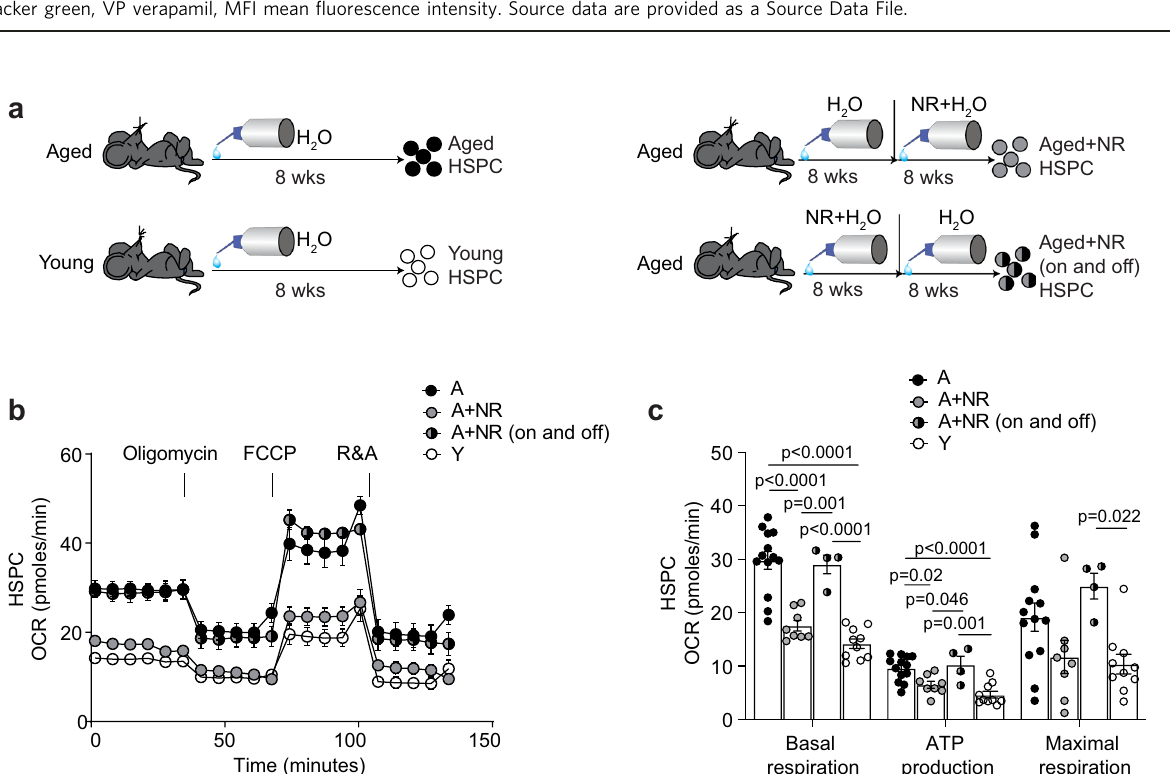
Fig. 5 NR treatment decreases stress response and mitochondrial network size. a mRNA expression levels of heat shock protein Hspa1a in aged ( n = 5, biological replicates), NR-treated aged ( n = 5, biological replicates) and young HSC ( n = 5, biological replicates). Data are expressed as box-and-whisker plots. Box indicates 25th to 75th percentile, the line indicates the median and whiskers indicate min to max values. Statistical analysis was performed using EdgeR package, false discovery rates between two groups were determined considering the third group as background. b Quanti fi cation of Hspa1a protein levels in aged ( n = 20, biological replicates), NR-treated aged ( n = 10, biological replicates) and young ( n = 7, biological replicates) HSPC via western blot assay. Data are mean ± s.e.m. and is a pool across three separate collection days. Statistical analysis was performed using Kruskal – Wallis, p = 0.0019 (overall) with individual groups compared using Dunn ’ s multiple comparisons test, p -values indicated for c . Gene set activity analysis for positive regulators of mitophagy ( n = 5); the y axis shows the score as the area under the curve and has a unit of the standardised squared unit area in the range [0,1]. Data are expressed as box-and-whisker plots and is representative of a single experiment. Box indicates 25th to 75th percentile, the line indicates the median and whiskers indicate min to max values. Statistical analysis was performed using SCENIC based pipeline, employing a two-sided Student ’ s t -test; p -values adjusted for multiple testing using Benjamini – Hochberg (BH) correction method are indicated. d Representative Tom20 immuno fl uorescence staining (2D and 3D volumetric) and e 3D volumetric quanti fi cation of total cell mitochondrial network size ( μ m 3 )/HSC isolated from aged ( n = 7, biological replicates), NR-treated aged ( n = 5, biological replicates) and young ( n = 4, biological replicates) mice, two independent experiments with 15 – 20 HSC quanti fi ed from each biological sample in each experimental repetition. Scale bar = 5 μ m. Data are mean ± s.e.m. and statistical analysis was performed using Kruskal – Wallis, p = 0.0036 (overall) with individual groups compared using Dunn ’ s multiple comparisons test, p -values indicated. Determination of relative mitochondrial mass via Mitotracker green labelling in the presence of Verapamil; f representative histograms for mitotracker green level in HSPC and HSC from aged, NR-treated aged and young mice, and g relative quanti fi cation via mean fl uorescence intensity for HSPC and h HSC from aged ( n = 7, biological replicates), NR-treated aged ( n = 8, biological replicates) and young ( n = 5, biological replicates) mice. Data are mean ± s.e.m. and is representative of two independent experiments. Statistical analyses were performed using ordinary one-way ANOVA, p = 0.0005 (overall) with individual groups compared using Tukey ’ s multiple comparisons test, p -values indicated for g and Kruskal – Wallis, p = 0.012 (overall) with individual groups compared using Dunn ’ s multiple comparisons test, p -values indicated for h . NR nicotinamide riboside, A aged, A + NR NR-treated aged animal, MTG